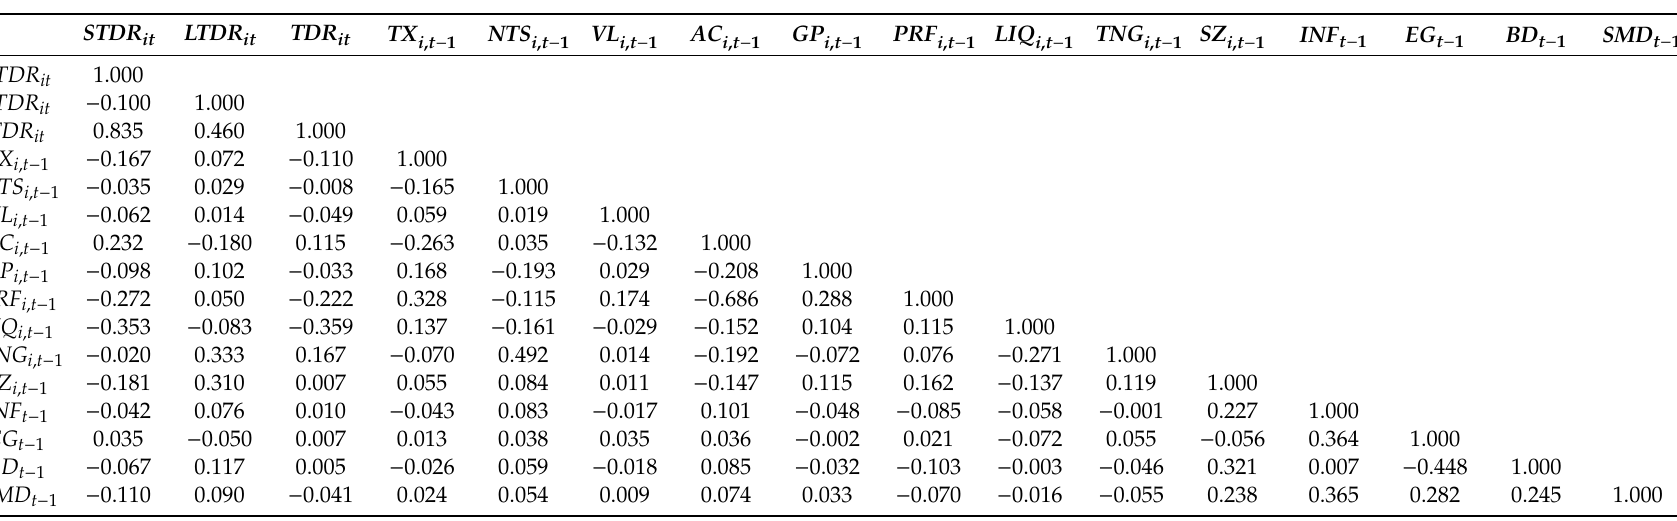
Table 6. Pair-wise Correlation (Less Competitive